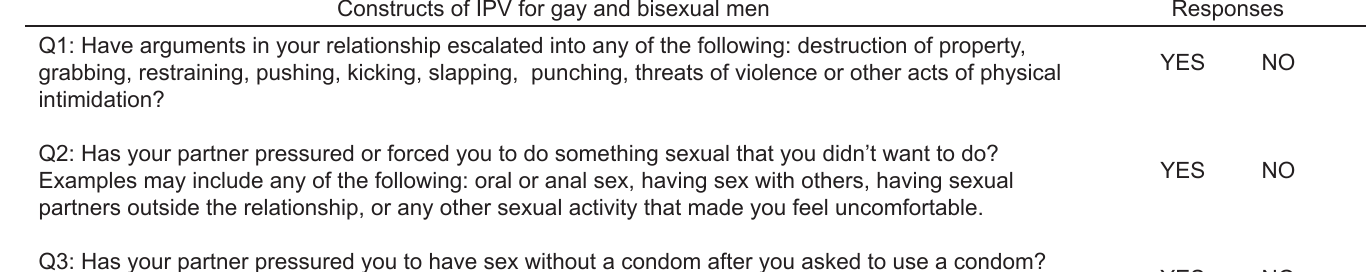
Table 3. Intimate partner violence (IPV) screening tool for gay and bisexual men. Constructs of IPV for gay and bisexual men